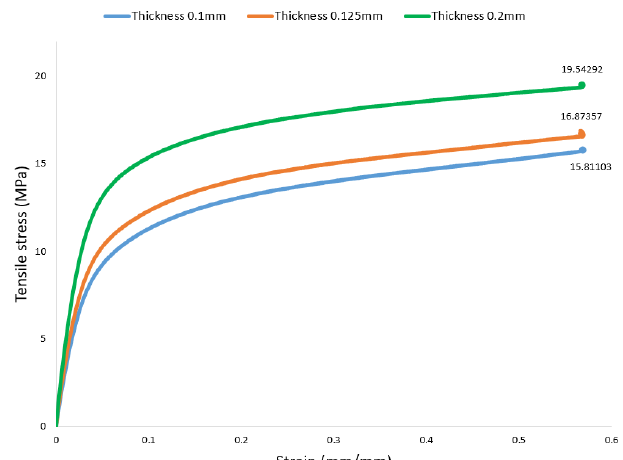
Figure 19. Effect of layer thickness on tensile strength of 3D-printed nylon.